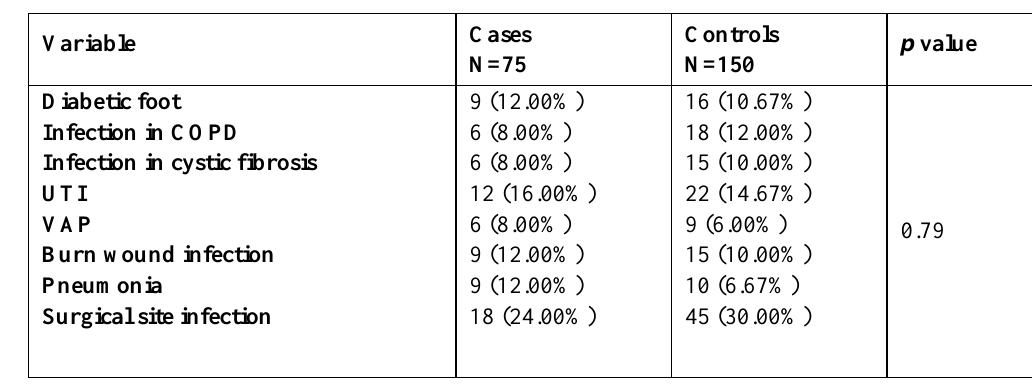
Table 2. Distribution of isolates among types of HAIs.